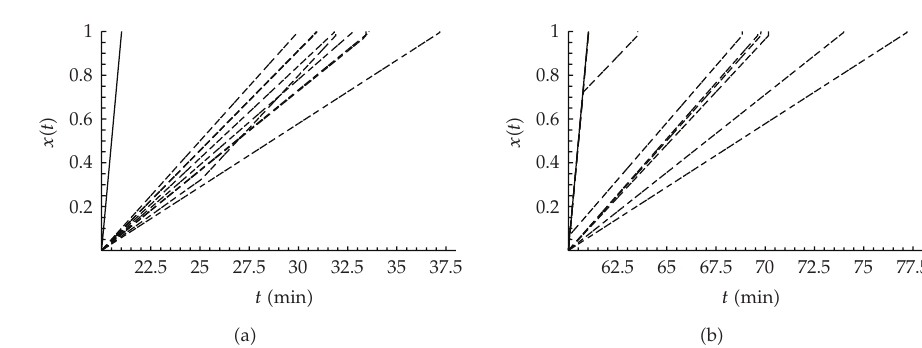
Figure 10: Evolution of a car trajectory x (cid:4) t (cid:7) along road g with initial travel times t 0 (cid:8) 20 (cid:4) a (cid:7) and t 0 (cid:8) 60 (cid:4) b (cid:7) , evaluated for optimal distribution coe ffi cients (cid:4) continuous lines (cid:7) and random choices (cid:4) dashed lines (cid:7) .